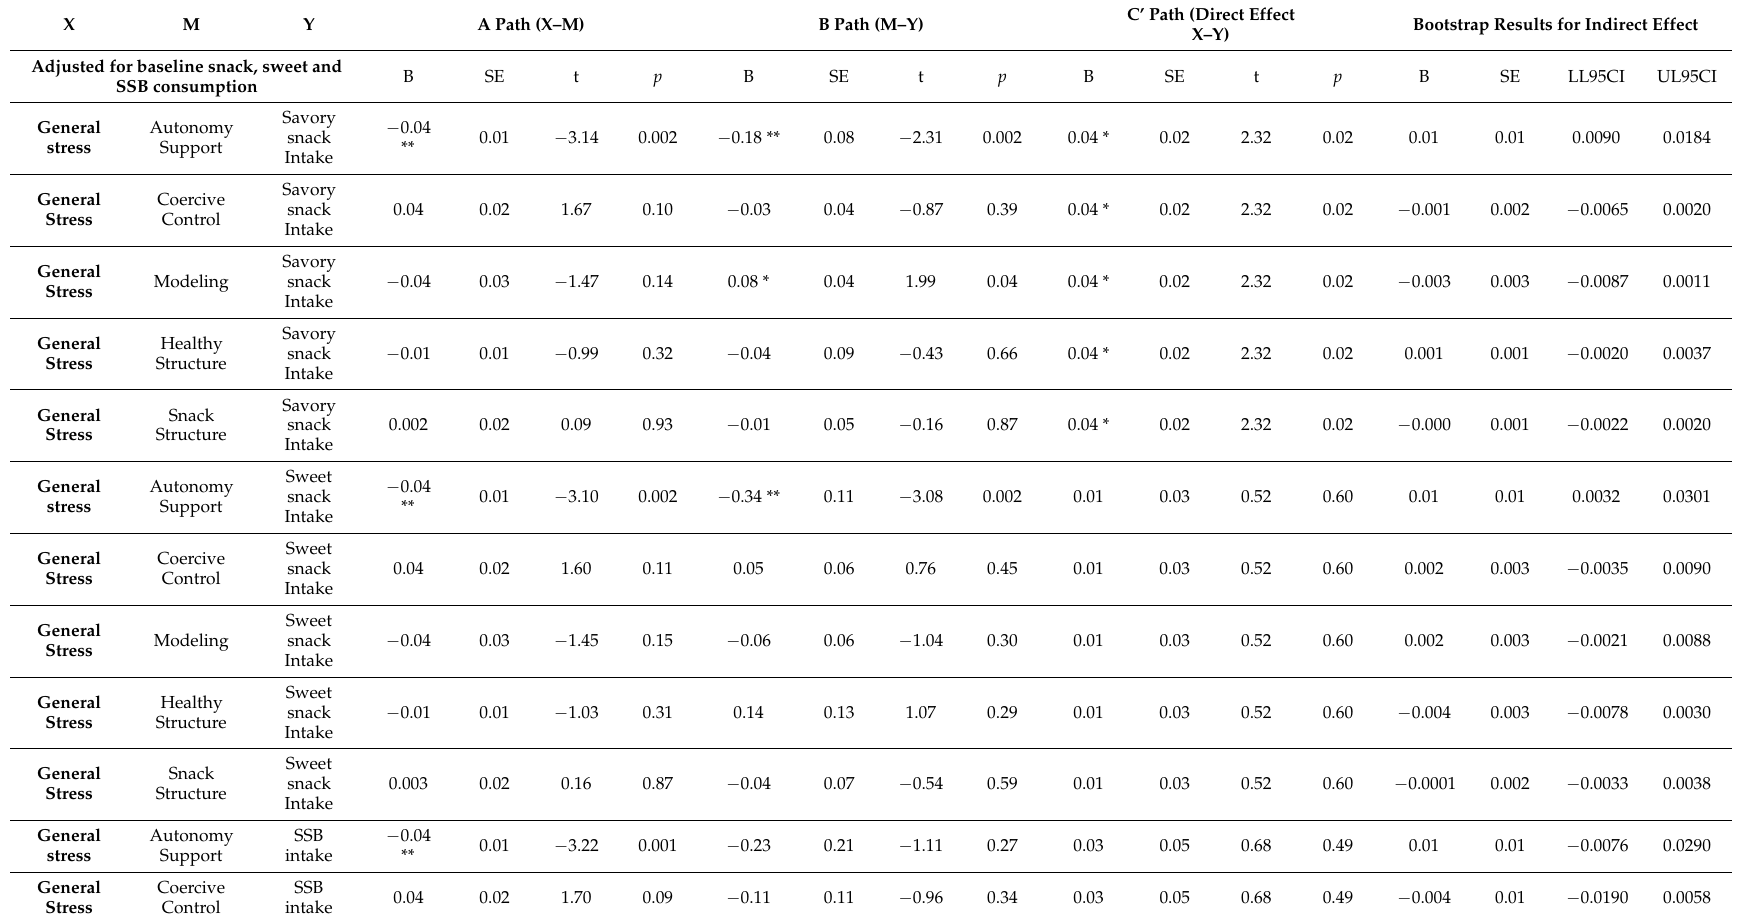
Table 3. Mediation analysis of the link between parental general stress at baseline (X) and adolescent snacking at follow-up (Y) by Food Parenting Practices at follow-up